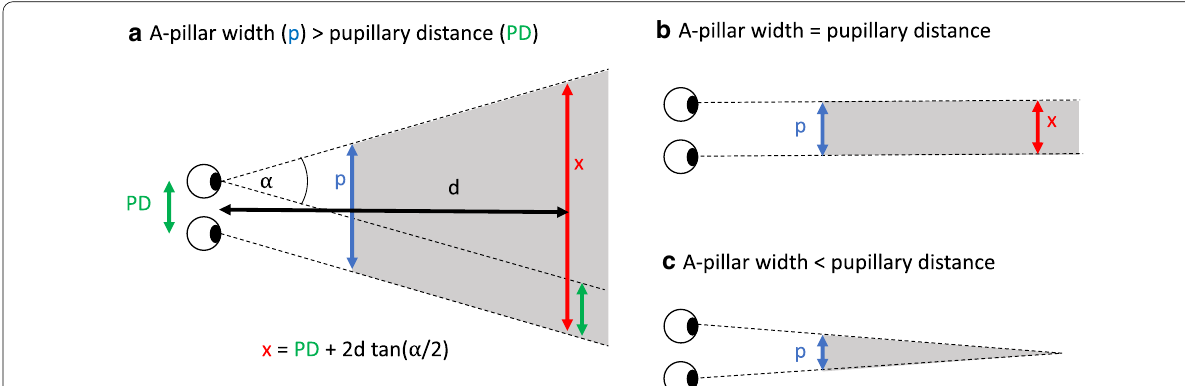
Fig. 4 Schematic illustration of the binocular blind zone (gray regions) created by A-pillars (blue arrows) of different widths. a If the A-pillar is wider than the distance between the pupillary distance PD—which is the case in most extant cars—, the width (x) of the blind zone increases with the distance (d) from the observer. b If the width of the A-pillar were equal to the pupillary distance, the width of the binocular blind zone would be equal to the pupillary distance (typically about 6 cm) at any distance. c If the width of the A-pillar were less than the pupillary distance, the width of the blind zone would decrease with distance. Panel ( a ) also illustrates the definition of the binocular obstruction angle α. The equation underneath shows how the width x of the binocular blind zone at a given distance d can be calculated based on the binocular obstruction angle and the interpupillary distance. In ( b ), the binocular obstruction angle is zero, and in (c) it is